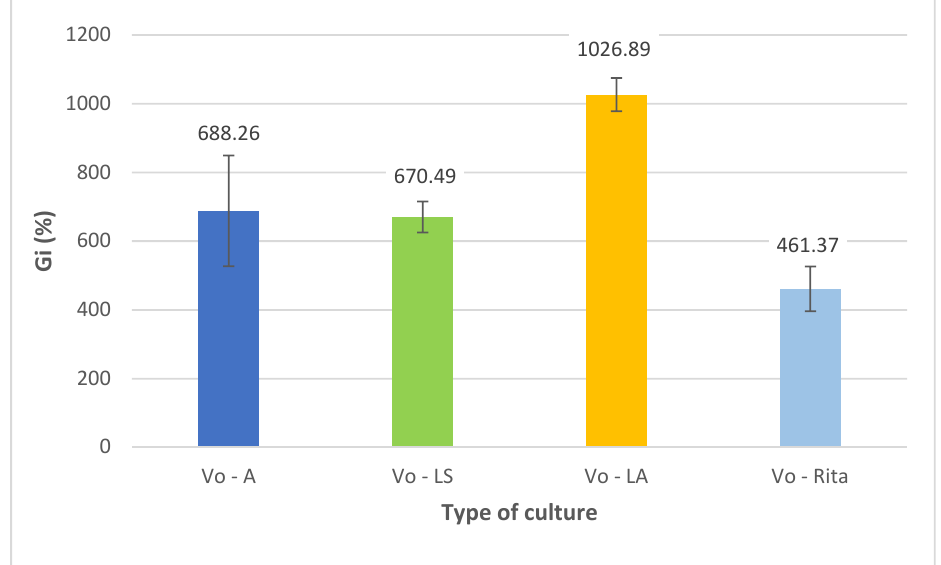
Figure 2. Comparison of the Gi values of V. officinalis microshoots grown in the investigated types of V. officinalis cultures; agar (Vo-A), stationary liquid (Vo-LS), agitated (Vo-LA), and bioreactor cultures (Vo-RITA).